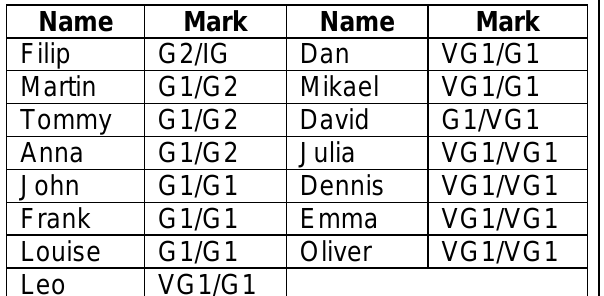
Table 2. Students’